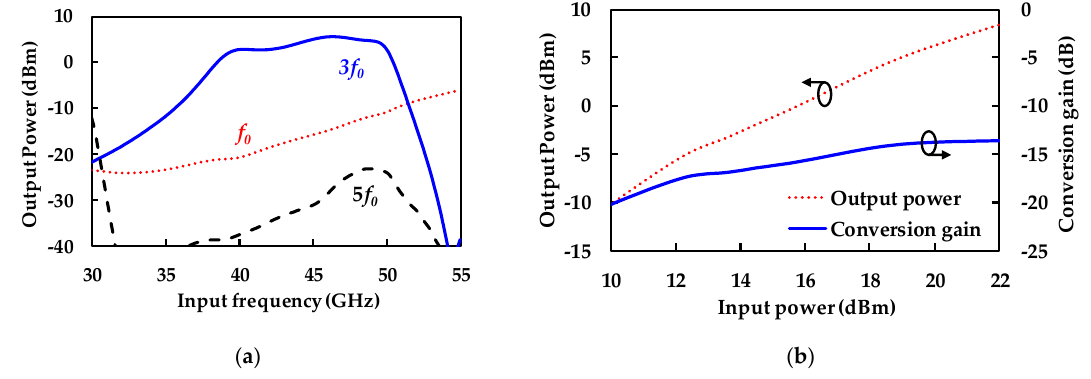
Figure 6. Simulated performance of designed frequency tripler. ( a ) Output power versus frequency with input power of 19.0 dBm. ( b ) Output power and conversion gain versus input power at input frequency of 45 GHz.